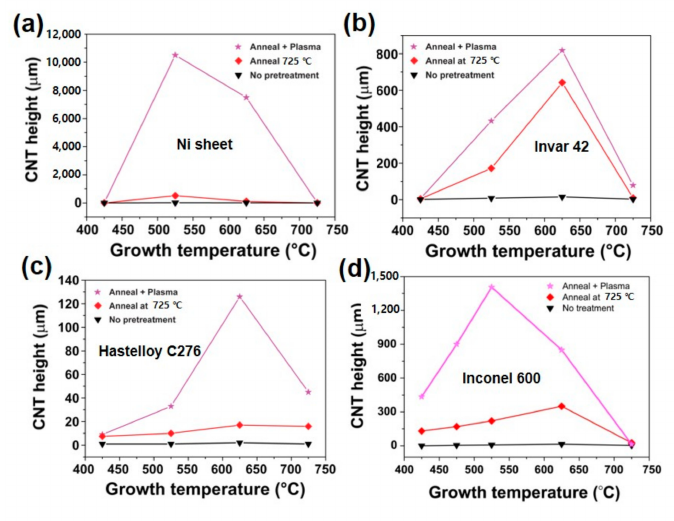
Figure 10. CNT growth results with respect to the growth temperature and pretreatment. ( a ) Ni sheet, ( b ) Invar 42, ( c ) Hastelloy C276 and ( d ) Inconel 600.